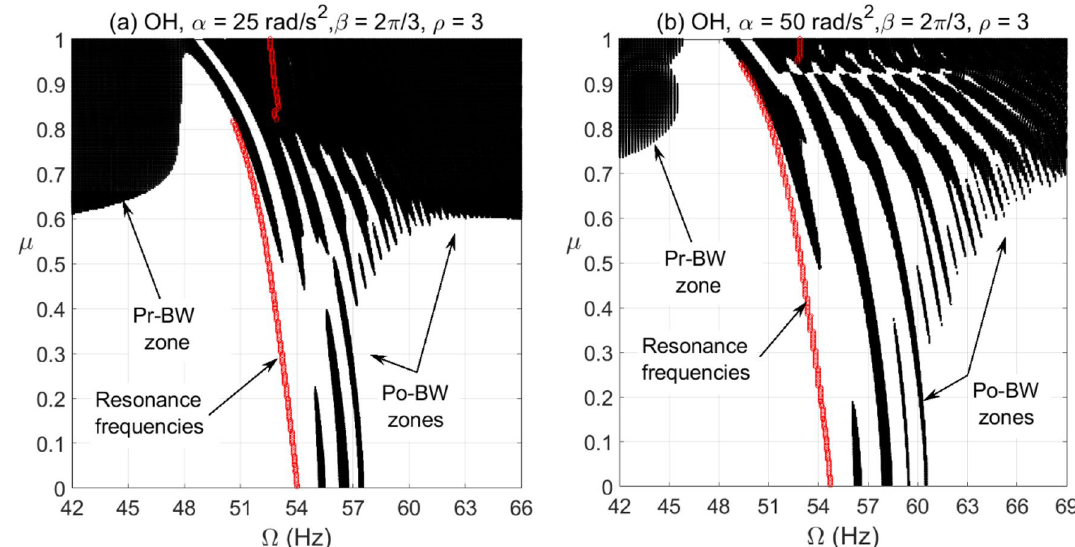
Figure 8. BW zones of rotational speeds at varying normalized crack depths of overhung cracked rotor system 2 in ( a ) at α = 25 rad/s and in ( b ) at α = 50 rad/s